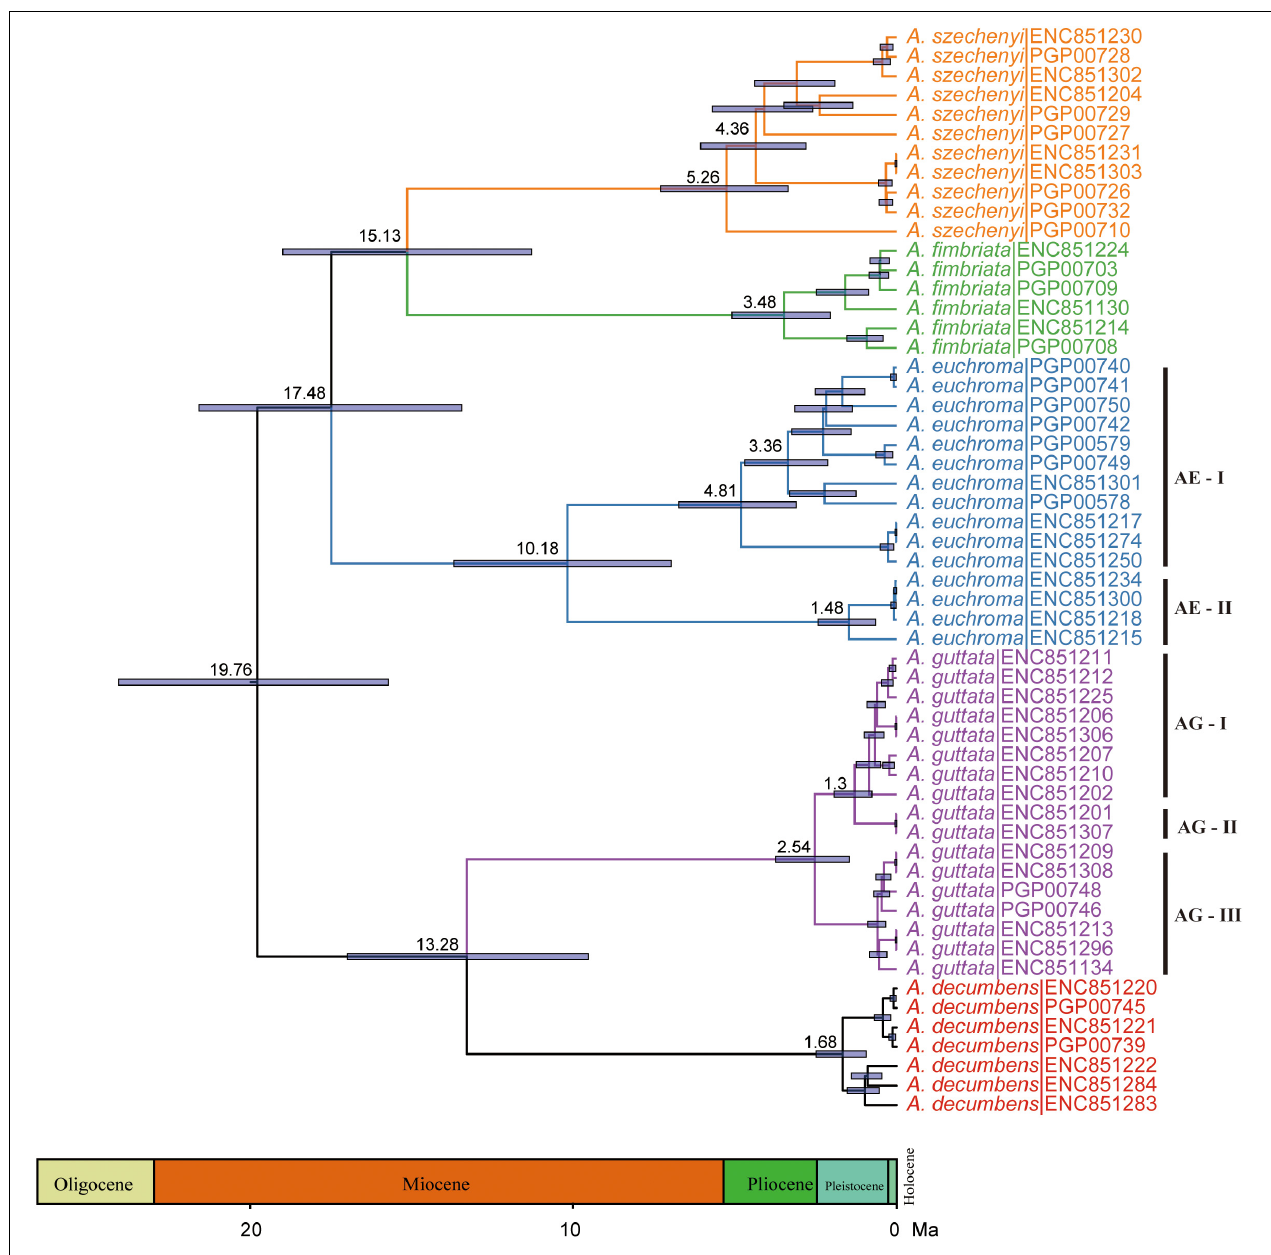
FIGURE 5 | Divergence times of Arnebia obtained from BEAST analysis based on the 65 whole chloroplast genomes. The mean divergence time of the nodes is shown next to the nodes, and the blue bars correspond to the 95%